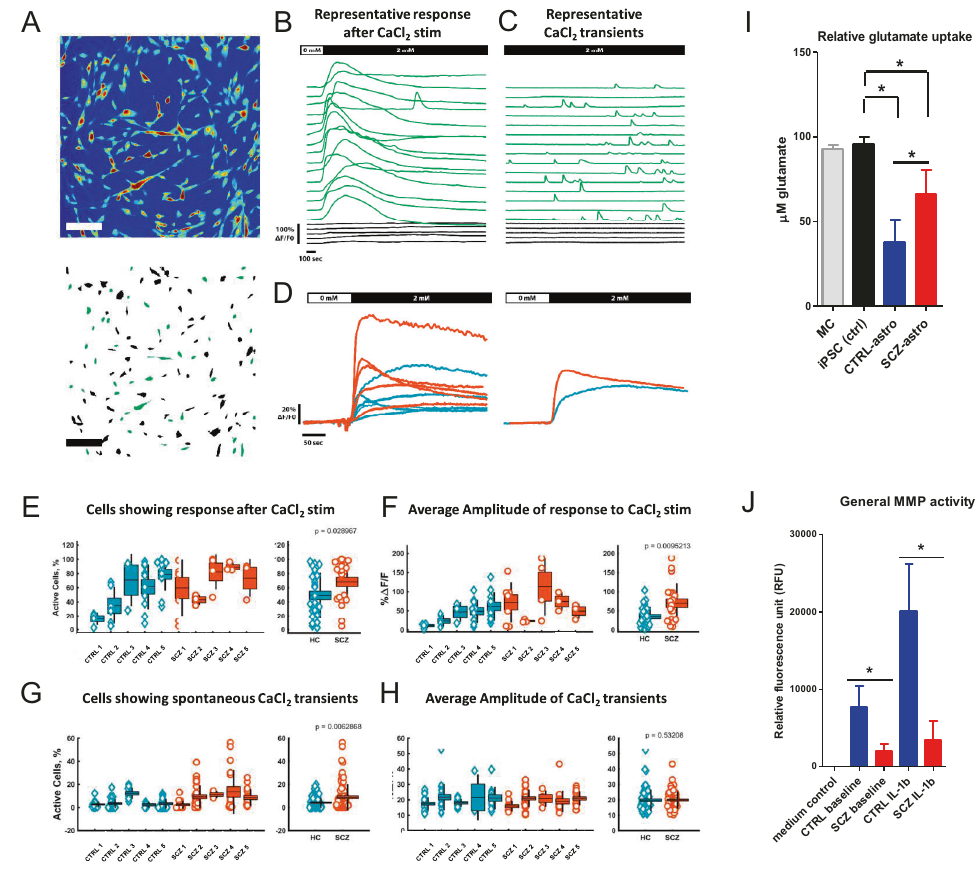
Fig. 6 Functional characterization of hiPSC-astroglia. A Top: Representative time projection image of a 2400 frame scan obtained by live-cell calcium imaging. Bottom: Representation of ROIs after segmentation, green ROIs are active cells. Scale bar equals 200 μ m. B Representative time course of astrocytes response to addition of 2 mM CaCl 2 in the calcium-free buffer after 60 s. Black lines are non-active cells. Green lines are active cells. C Representative time course of astrocytes ’ spontaneous CaCl 2 transients over a 20 min time period. D Averaged time courses of the Calcium response of each clone (left) and, CTRL and SCZ clones compared (right). E Percentage of astrocytes with a response to the addition of 2 mM CaCl 2 in the calcium-free buffer for each clone (left), and CTRL and SCZ clones compared (right). F Average amplitude of the response to the CaCl 2 stimulation of the active cells for each clone (left), and CTRL and SCZ clones compared (right). G Percentage of astrocytes with spontaneous CaCl 2 transients for each clone (left), and CTRL and SCZ clones compared (right). H Average amplitude of CaCl 2 transients for each clone (left), and CTRL and SCZ clones compared (right). I Glutamate uptake of resting iPSC astrocytes was assessed using a glutamate assay kit. Native AM cell medium (MC, ‘ medium control ’ ), and donor/clone-speci fi c iPSC lines were used as controls (iPSC ctrl). Data of triplicate measurements of fi ve independent donors per group are presented as mean ± SEM (in the case of MC, triplicate measurements were performed by sampling the same bottle of medium in which all cells were cultured). Asterisks represent signi fi cant differences relative to iPSC controls, and CTRL astrocytes versus SCZ astrocytes at p < 0.05. J General matrix metalloproteinase activity was measured at both baseline and following cell activation by 10 ng/ml IL-1 β for 24 h. Samples from empty wells containing only AM medium were used as medium (negative) control. Fluorescence intensity was measured at E x / E m = 540/590 nm, and MMP activity is shown in relative fl uorescence units (RFU). Data of triplicate measurements of fi ve independent donors per group are presented as mean ± SEM. Asterisks represent signi fi cant differences at p -values